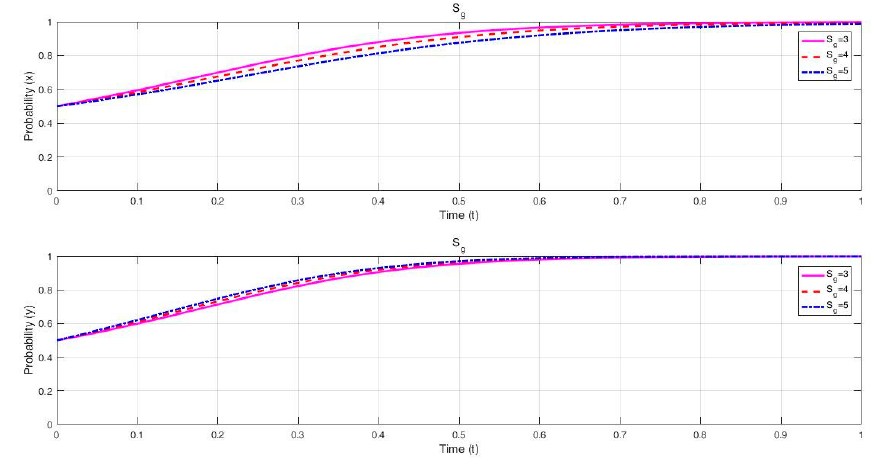
Figure 6. The impact of S g on the game.